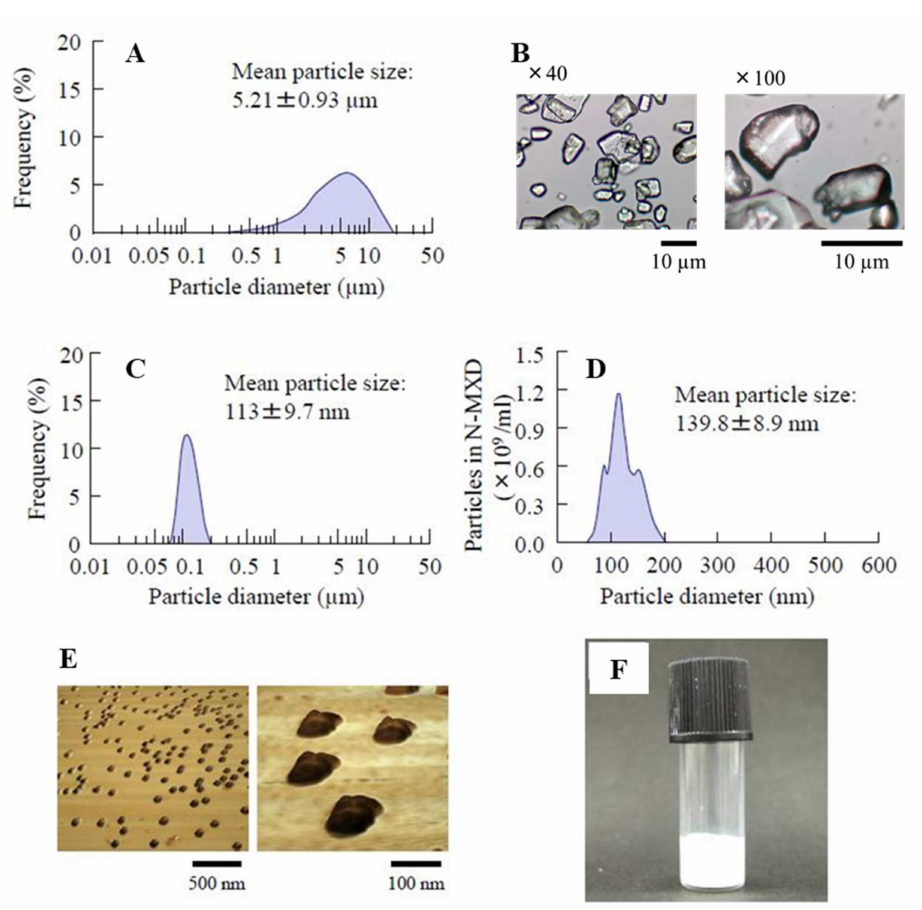
Figure 1. Distribution of MXD particle sizes with and without a bead mill. ( A ) The particle size distributions for MXD-MPs without a bead mill, and ( B ) Images of MXD-MPs without a bead mill. The data were measured using the SALD-7100 and the Motic BA210E, respectively. ( C , D ) The particle size distributions for MXD-NPs with a bead mill. The data were measured using the SALD-7100 and NANOSIGHT LM10, respectively. ( E ) AFM images of MXD-NPs with a bead mill. ( F ) Digital photo of MXD-NPs with a bead